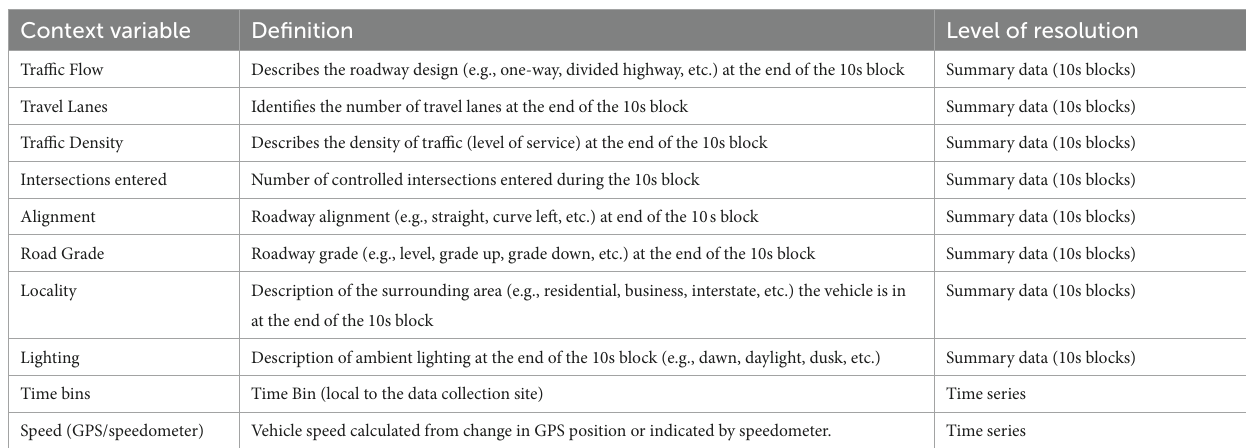
TABLE 1 Context variables definitions and resolution levels.